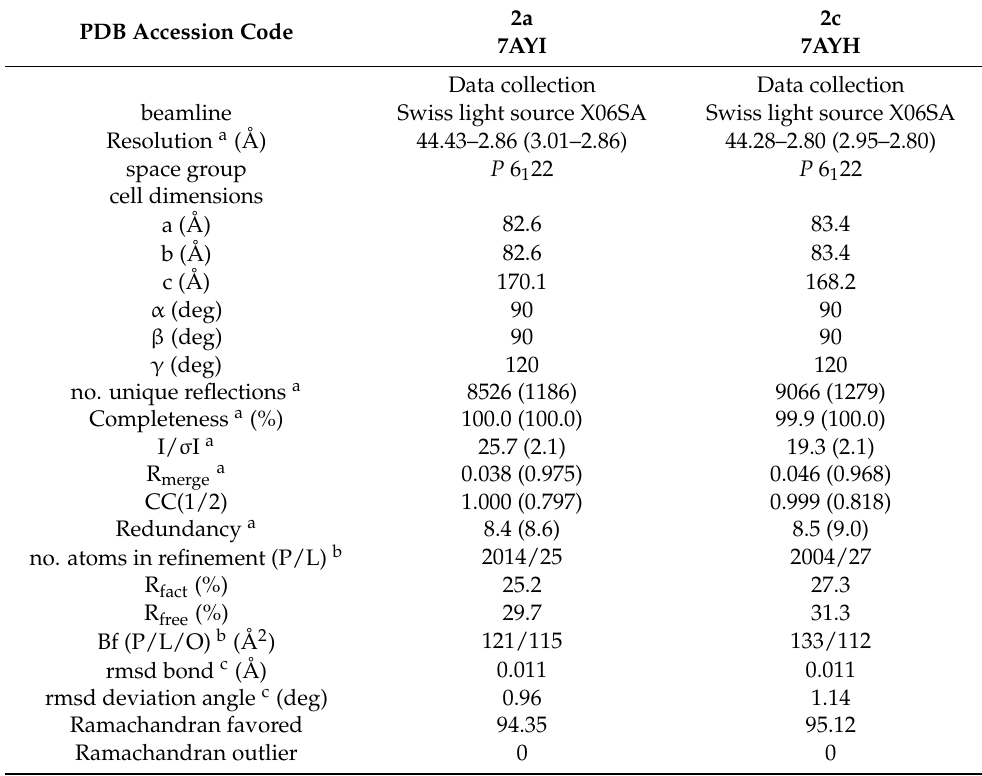
a Values in brackets show the statistics for the highest resolution shells. b P/L indicate protein and ligand molecule respectively. c rms indicates root-mean-square deviation.